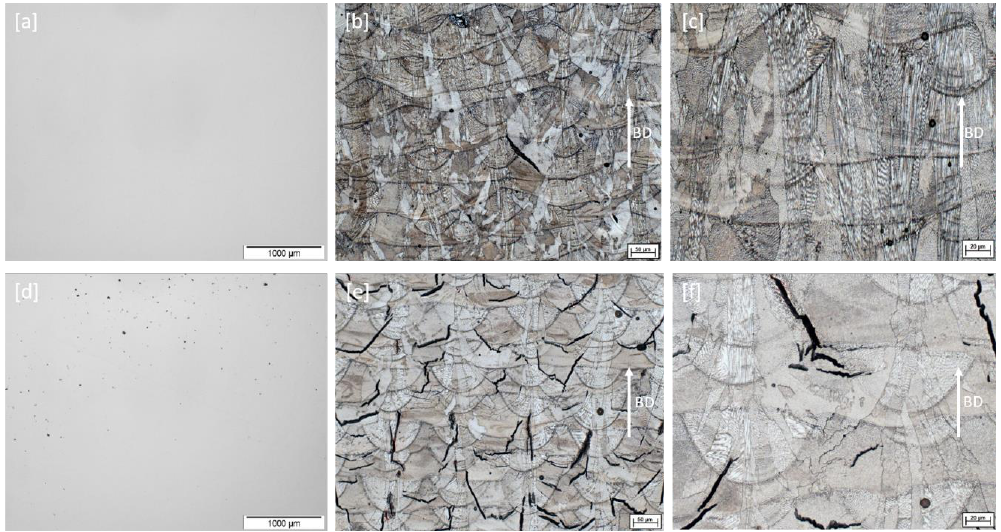
Figure 3. ( a – c ) Dense 80 µm hatch distance cube (etched and unetched) built at 1000 mm/s; ( d – f ) 80 µm hatch distance cube (etched and unetched) built at 1500 mm/s showing a high number of cracks.